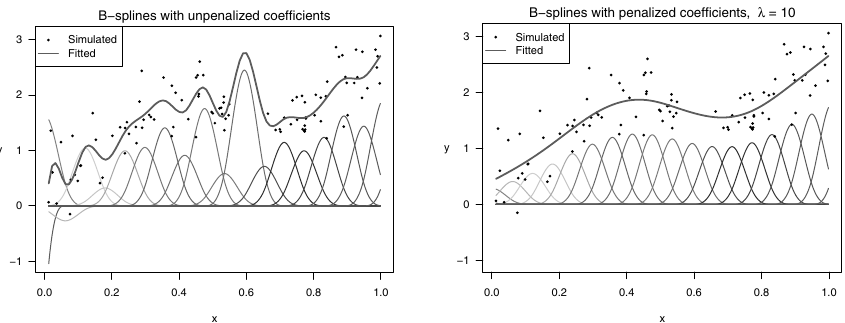
Figure 1 – Unpenalized (left panel) and penalized regression (right panel). Simulated data fitted using